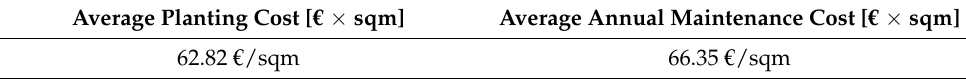
Table 7. Planting and maintenance costs in euros per square